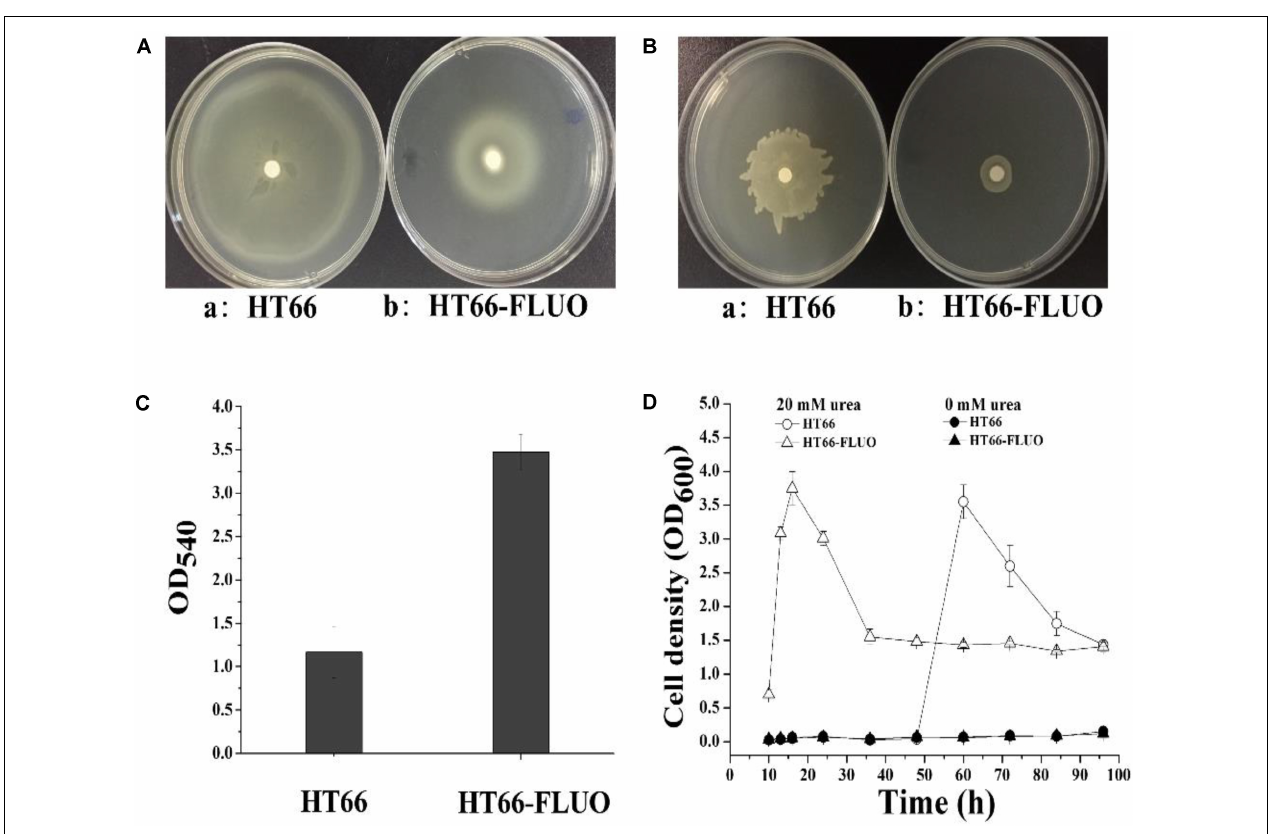
FIGURE 6 | (A) Twitching motility (1% agar) and (B) swarming motility (0.5% agar) of P. chlororaphis HT66 and HT66-FLUO that incubated at 28 ◦ C for 20 h. (C) Biofilm formation by P. chlororaphis HT66 and HT66-FLUO. (D) Growth of HT66 and HT66-FLUO in liquid M9 medium with or without urea as sole nitrogen